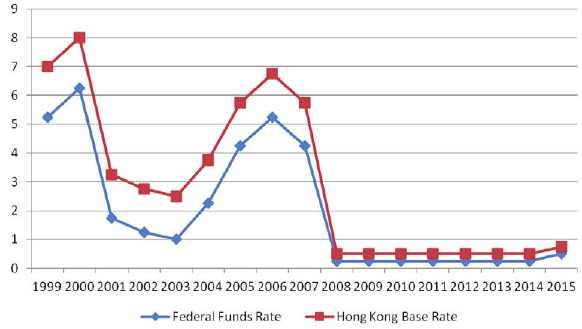
Figure 6. U.S. Federal Funds rate and Hong Kong base